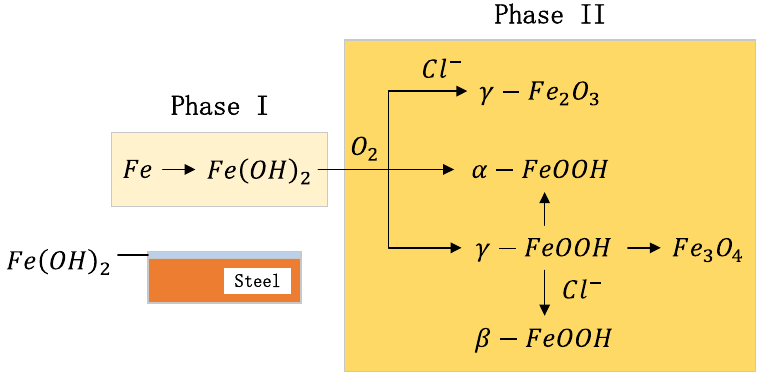
Figure 1. Marine atmospheric corrosion mechanism of steel.